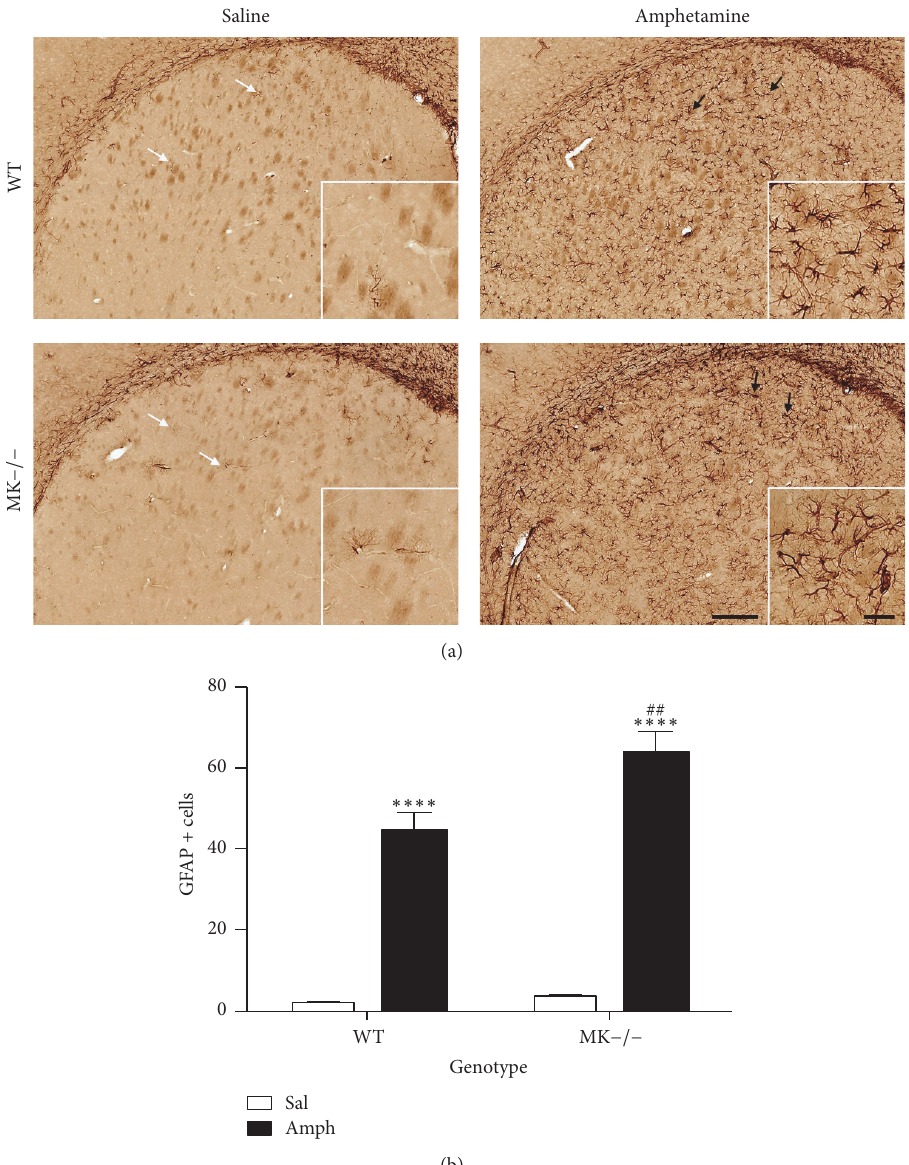
Figure 1: Amphetamine induces astrocytosis in the striatum of WT and MK − / − mice. (a) Photomicrographs are from GFAP-immunostained striatal sections of saline- (Sal-) or amphetamine- (Amph-) treated animals. Amphetamine induced reactive astrocytes characterized by larger densely stained bodies with longer and extensive processes (black arrows) compared to saline-treated mice (white arrows). (b) The graph represents quantification of data (mean ± SEM) obtained from the counts of GFAP-positive cells in standardized areas of the striatum. Significant effects of the genotype ( F (1,16) = 8.051, 𝑃 = 0.01 ), the treatment ( F (1,16) = 200.3, 𝑃 < 0.0001 ), and genotype by treatment variant interaction ( F (1,16) = 5.896, 𝑃 = 0.03 ) were found. ∗∗∗∗ 𝑃 < 0.0001 versus Sal. ## 𝑃 < 0.01 versus WT. Scale bar = 200 𝜇 m. Magnified inset = 50 𝜇